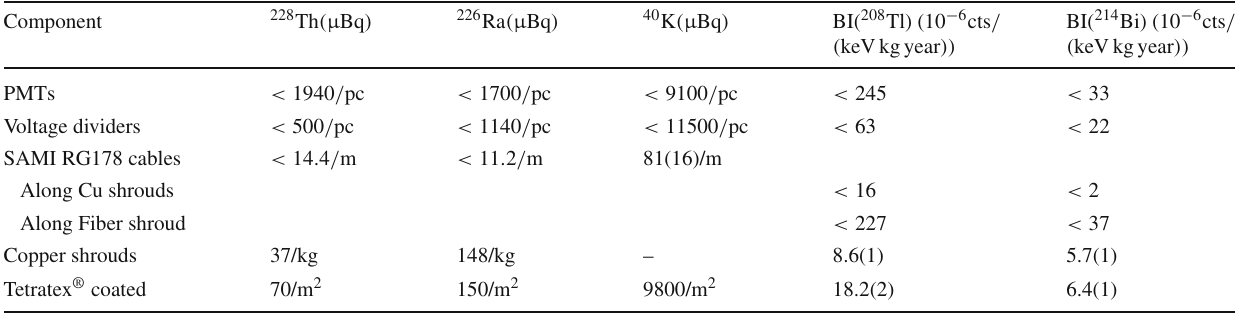
Table 9 Activity of the components of the PMT LAr veto system and their estimated background contribution BI at Q ββ after anti-coincidences but before the LAr veto and PSD. (pc: piece) Component